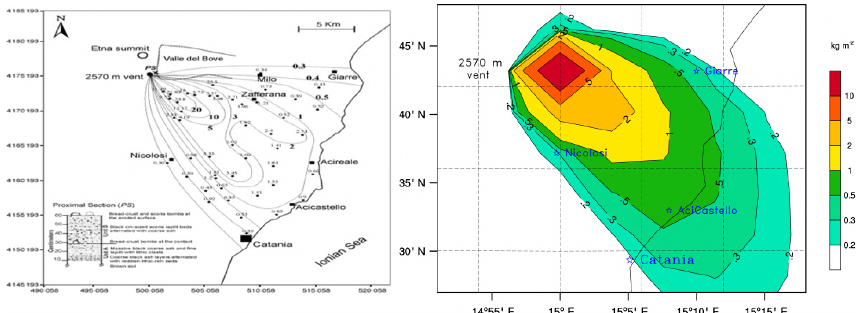
Figure 9. Left panel: isomass map of the tephra deposit for the 2001 Mount Etna eruption formed between 21 and 24 July. Curves are given in kgm − 2. Coordinates are given in UTM-Datum ED50 (Scollo et al., 2007). Right panel: modeled deposit load (kgm − 2 ) with NMMB- MONARCH-ASH at the end of the event.